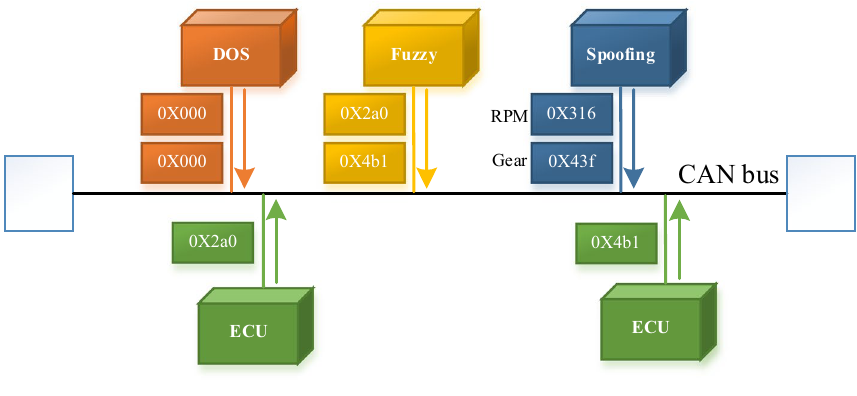
Figure 1. Illustration of the multiple